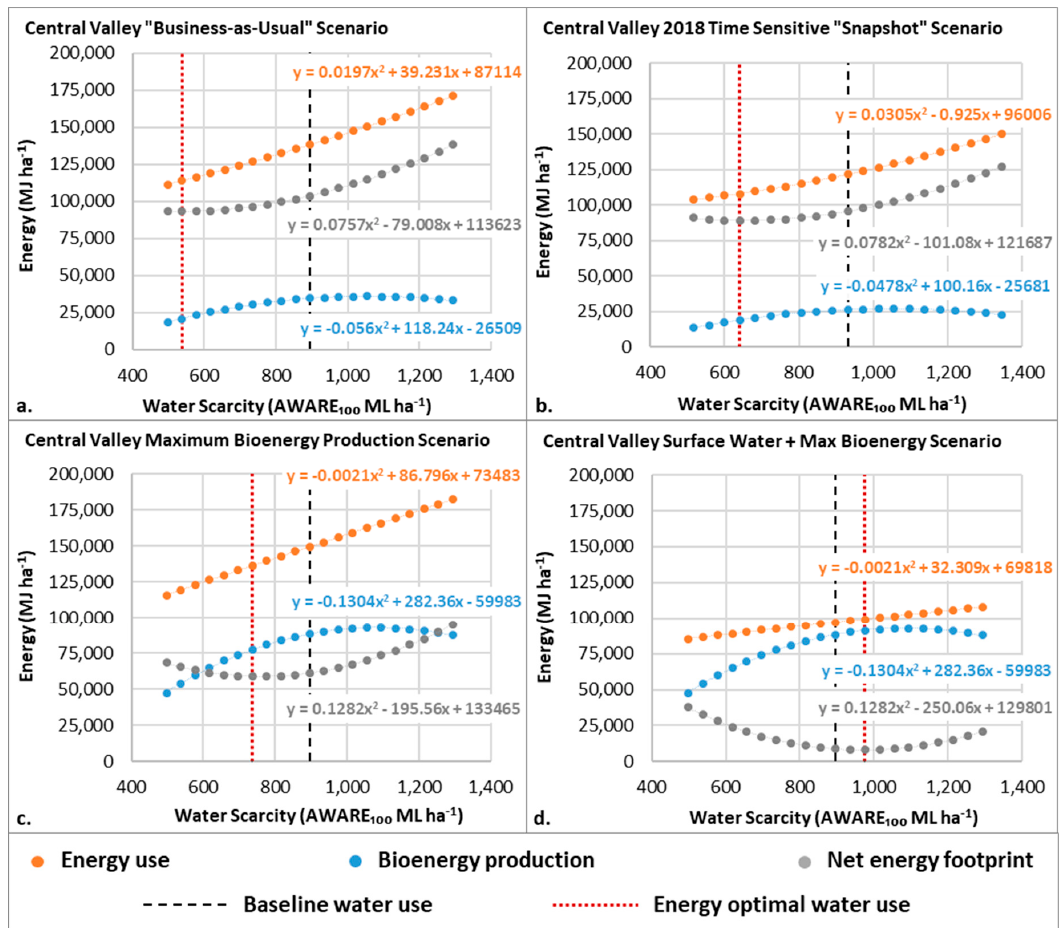
Figure 4. Mean annual biomass energy production from almond residue, as a function of applied water under four scenarios. ( a ) A business-as-usual (BaU) representing a ‘typical’ almond orchard in the Central Valley, with water demand and biomass productivity area-weighted to account for regional variation. ( b ) An age-weighted snapshot of the Central Valley almond landscape in 2018, accounting for the regional distribution of almond acreage at different stages in the orchard life cycle and corresponding water demand, probability of orchard removal, and availability of bioenergy production as a sink for orchard biomass coproduct. ( c ) As in BaU scenario (b), except all biomass co-product is directed to bioenergy production. ( d ) As in Bioenergy scenario (c), except irrigation water is obtained from surface sources, reducing pumping energy demand.